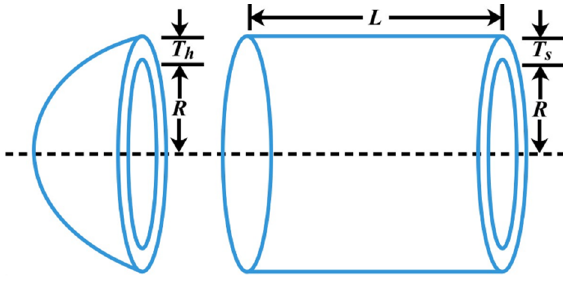
Figure 8. Design of a pressure vessel problem.